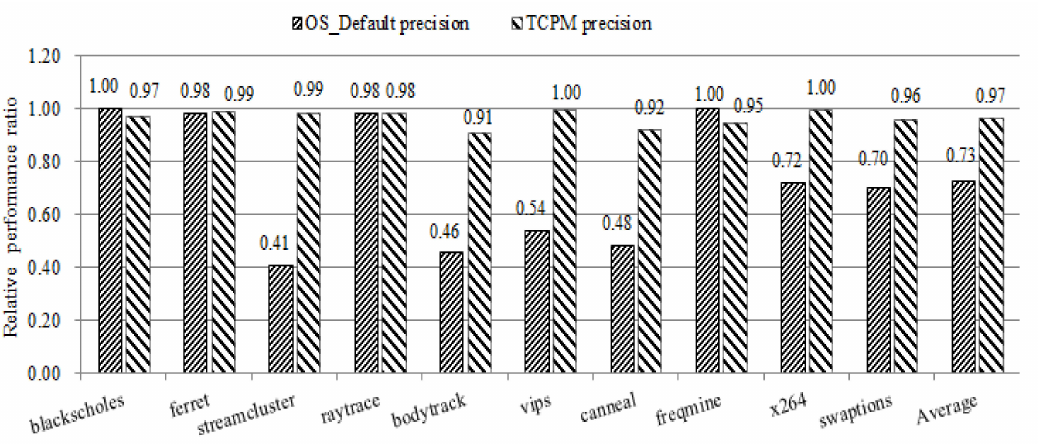
Figure 5. The comparison of relative performance ratio between OS_Default and the thread count prediction model